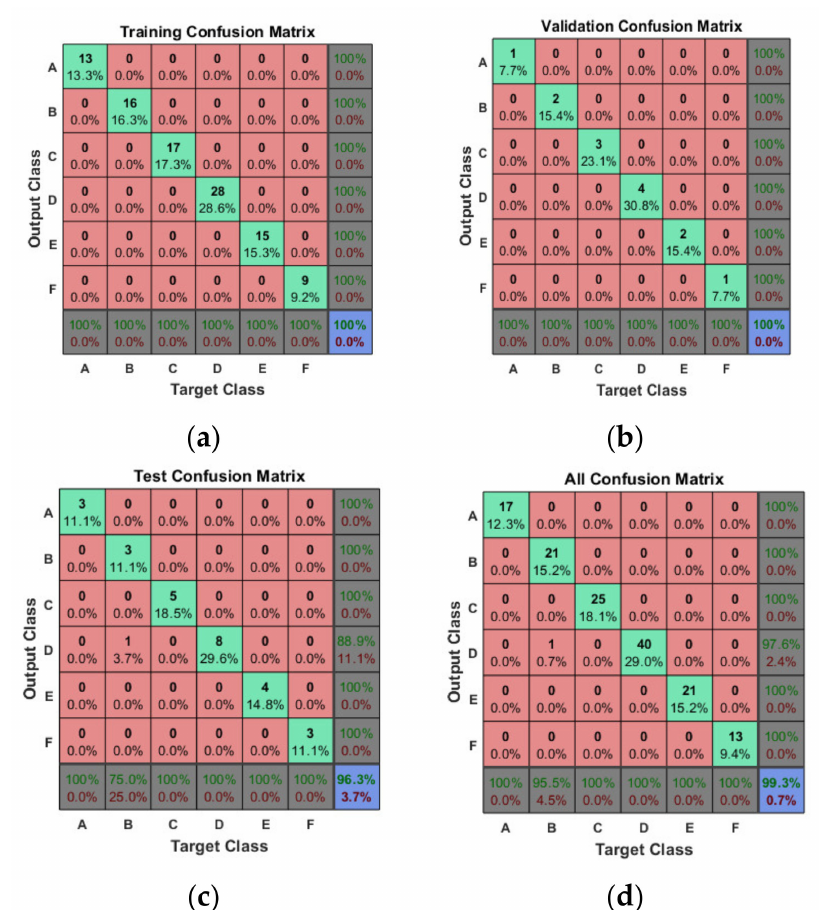
Figure 17. The confusion matrices of ANN trained with CSD feature set: ( a ) training confusion matrix, ( b ) validation confusion matrix, ( c ) testing confusion matrix, and ( d ) overall confusion